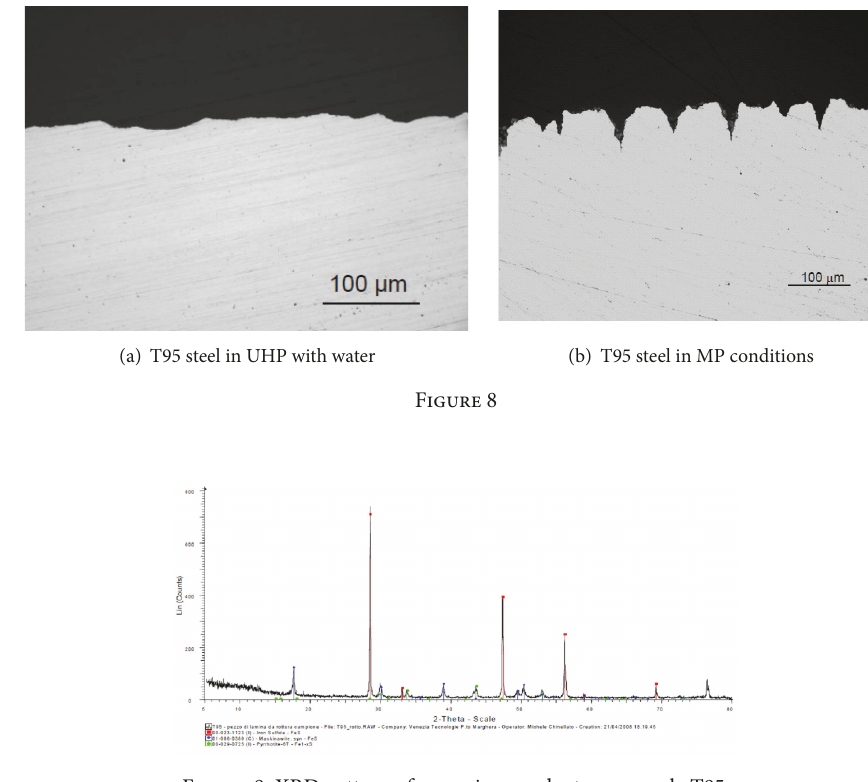
Figure 9: XRD pattern of corrosion products on sample T95.